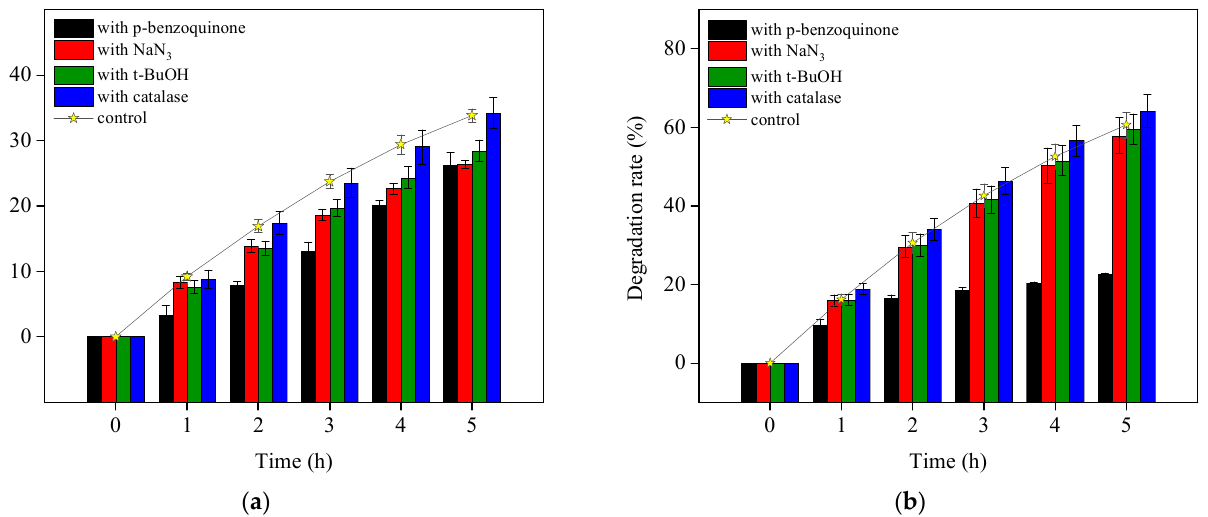
Figure 4. OTC photolysis with the addition of different ROS scavengers under visible light irradiation at pH 8.6 ( a ) and 11.5 ( b ). Experimental conditions: [OTC] 0 = 10 mg L − 1 , [NaN 3 ] 0 = 10 mM, [t-BuOH] 0 = 10 mM, [ p -benzoquinone] 0 = 5 mM, [catalase] 0 = 12 unit L − 1 , 50 mM phosphate buffer.